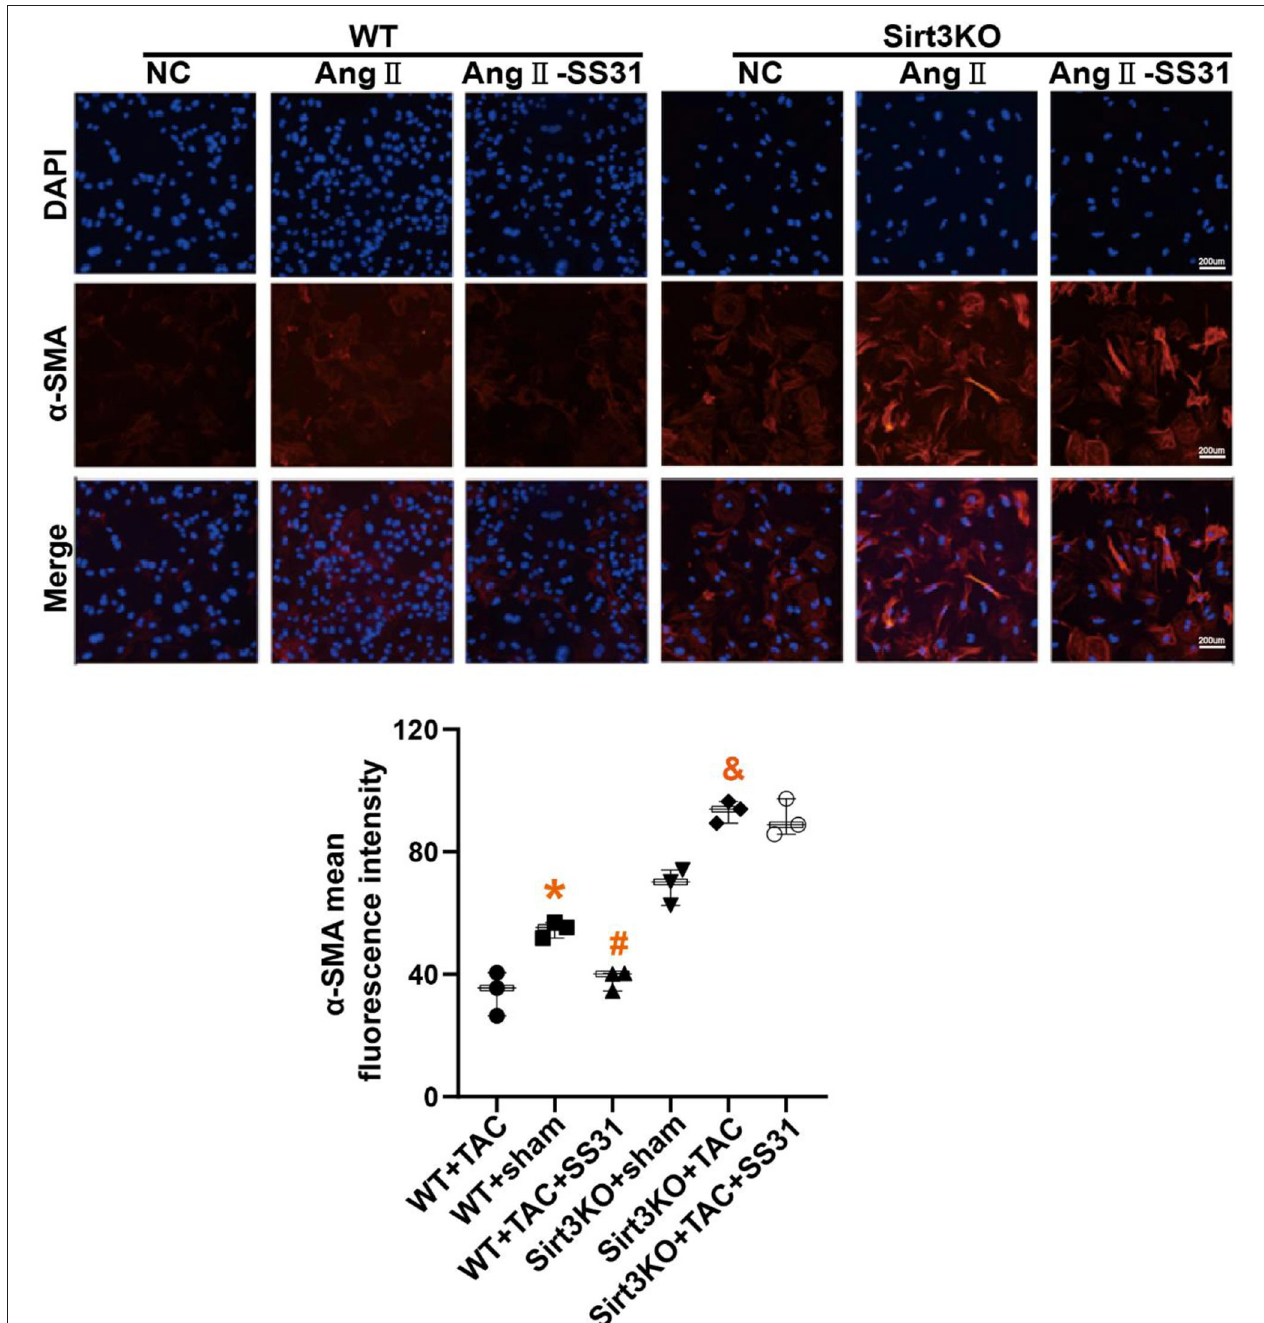
FIGURE 4 | SS31 inhibits the transdifferentiation of cardiac fibroblasts induced by angiotensin II. The expression of α -SMA in fibroblasts was shown by immunofluorescence staining (red). DAPI stains the nucleus (blue). * p < 0.05. WT + TAC vs. WT + sham, # p < 0.05. WT + TAC + SS31 vs. WT + TAC, & p < 0.05. Sirt3KO + TAC vs. Sirt3KO +